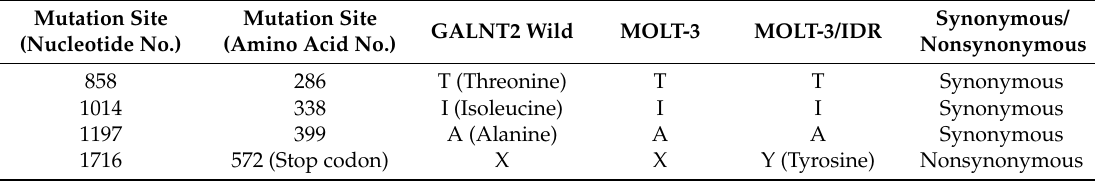
Table 3. Amino acid mutation sites identified within GALNT2 in MOLT-3 and MOLT-3/IDR cells.